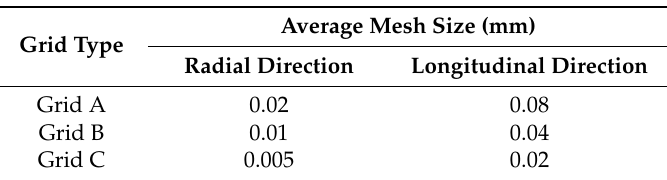
Table 4. Dimensions of mesh cells in different mesh